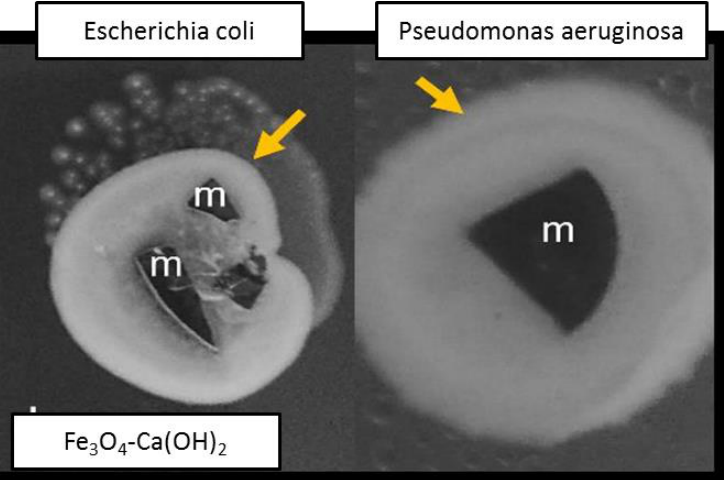
Figure 7. The bacteriostatic effect of Fe 3 O 4 -Ca(OH) 2 against E. coli and P. aeruginosa bacterial strains; arrows — bacterial strain hallow, m — material.